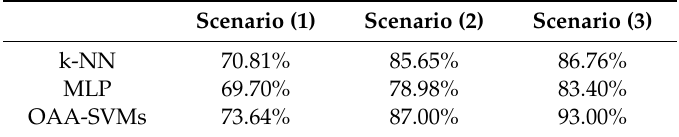
Figure 7. Wavelet scalogram extracted from normal ( left ) and leakage ( right ) cases of 2 mm hole and 1 mm hole. Table 2. Average classification accuracy of the k-NN, MLP and the proposed